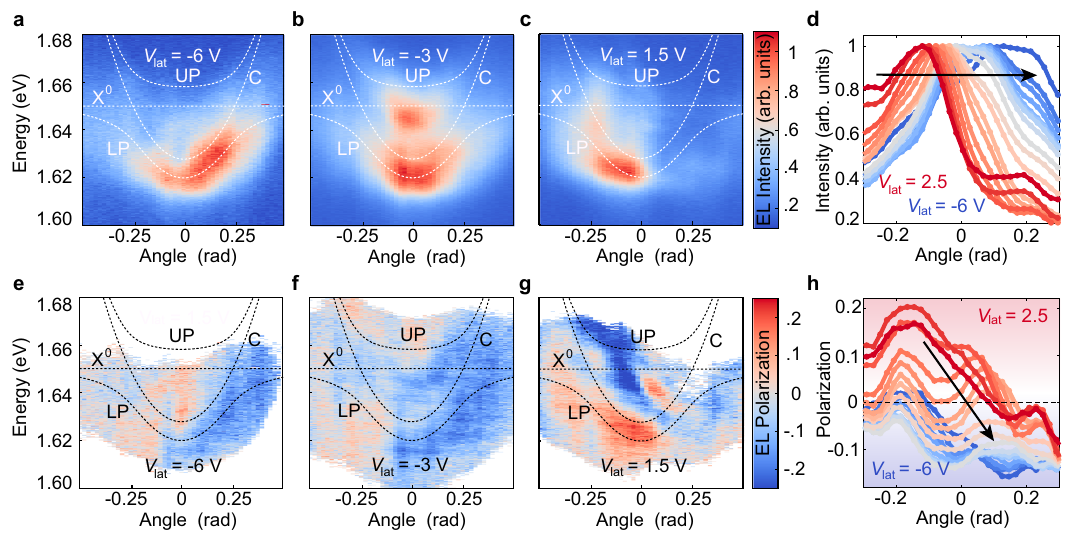
e – g Polarization-resolved EL dispersion as a function of emission angle at three different lateral voltages. Data points with emission intensity comparable to the background counts are not shown. h Circular polarization along the calculated LP branch displayed as a function of the emission angle. The data shown in ( d , h ) is averaged over an energy Δ E =1/2 k B T